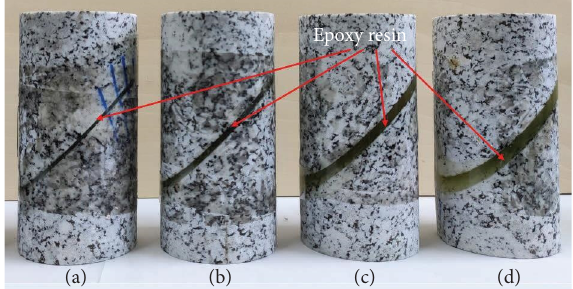
Figure 23: Epoxy resin-repaired samples with diferent repair widths (a) 1mm; (b) 3mm; (c) 5mm; and (d) 7mm before failure.